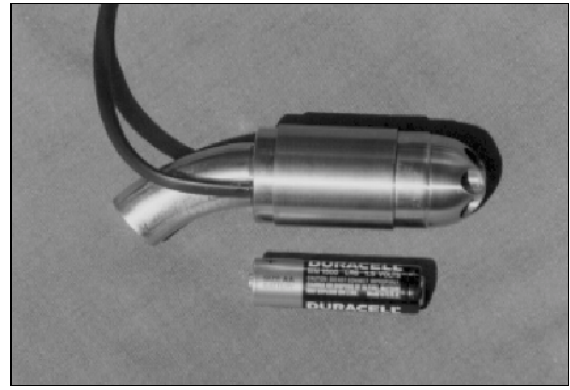
Fig. 1 - Aspecto externo do dispositivo comparado a uma pilha tamanho AA.